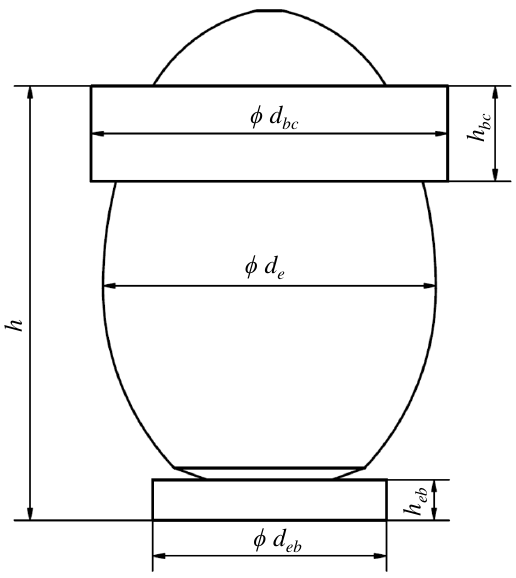
Figure 3. The demonstrator of the fish farm